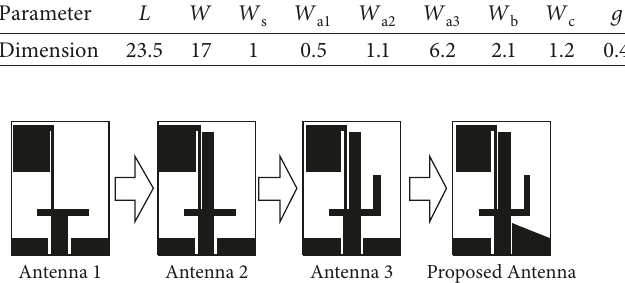
Figure 2: Evolution of the WLAN/WiMAX triband compact printed